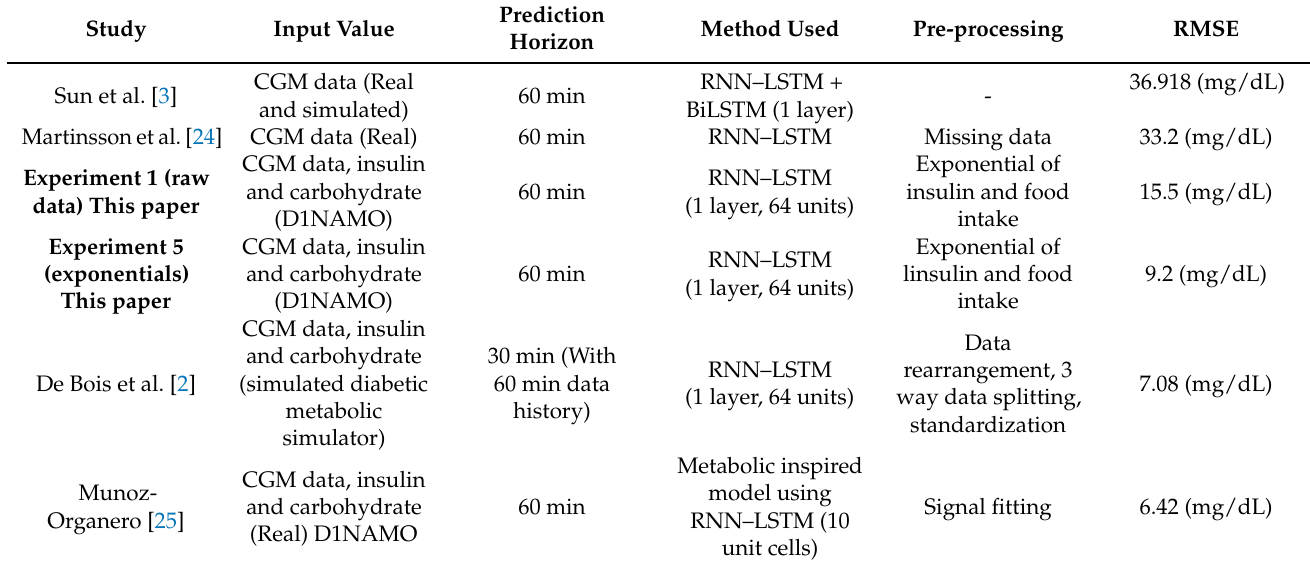
Table 8. Results of glucose predictions in a comparative study. Source: “Deep Physiological Model for Blood Glucose Prediction in T1DM Patients”